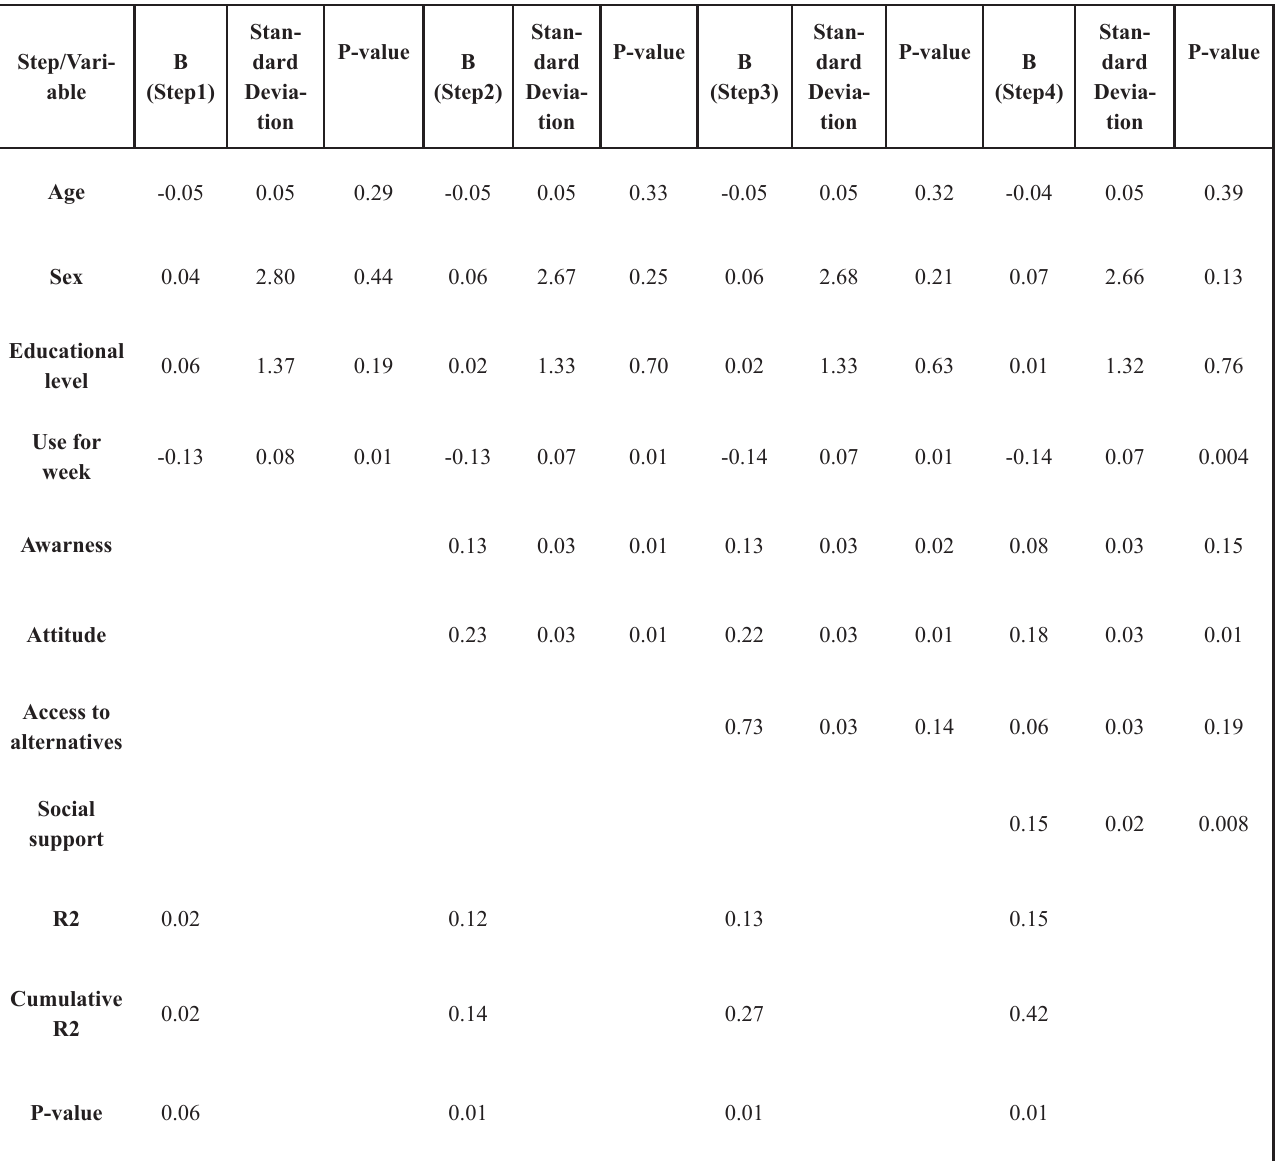
Table 3. Predicting power of demographic variables, levels of individual, social, and environmental factors contributing in the behavior of plastic bags use among the vendors using hierarchical regression